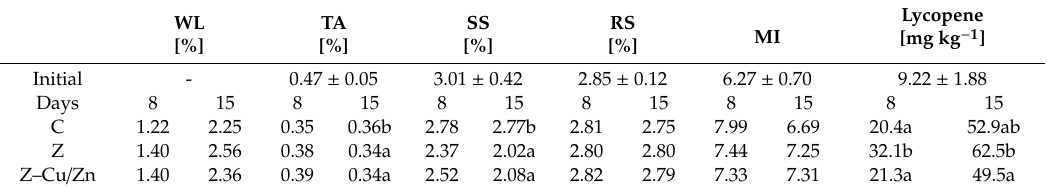
Table 3. Physicochemical and ripening indices of tomatoes stored at 20 °C without (control), in the presence of zeolite (Z) or modified zeolite (Z–Cu/Zn) 1 .